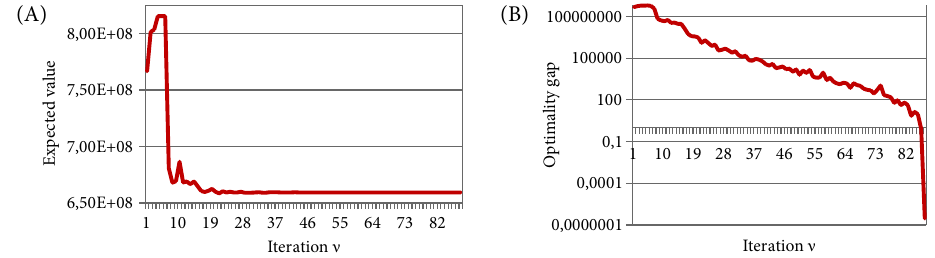
Fig. 2. Stochastic solution values during the